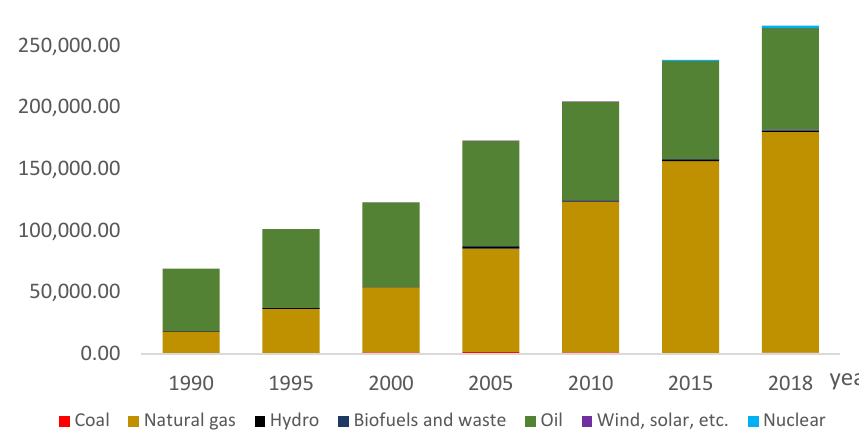
Figure 1. Comparison of supplied energy by various sources, 1990–2018 [9].